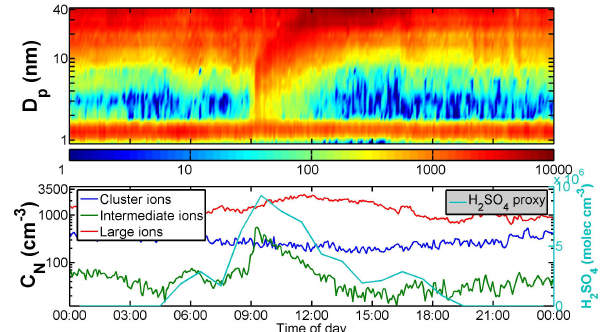
Fig. 9. The nucleation event measured on 2 November 2010 by the NAIS and the H 2 SO 4 proxy concentration. The upper panel shows naturally positively charged particle number size distribution (0.8–42nm) measured with the NAIS on 2 November 2010. The lower panel shows number concentrations of cluster ( < 1.8nm), in- termediate (1.8–7nm) and large (7–42nm) ions. The sulphuric acid (H 2 SO 4 ) proxy concentration is shown on the right